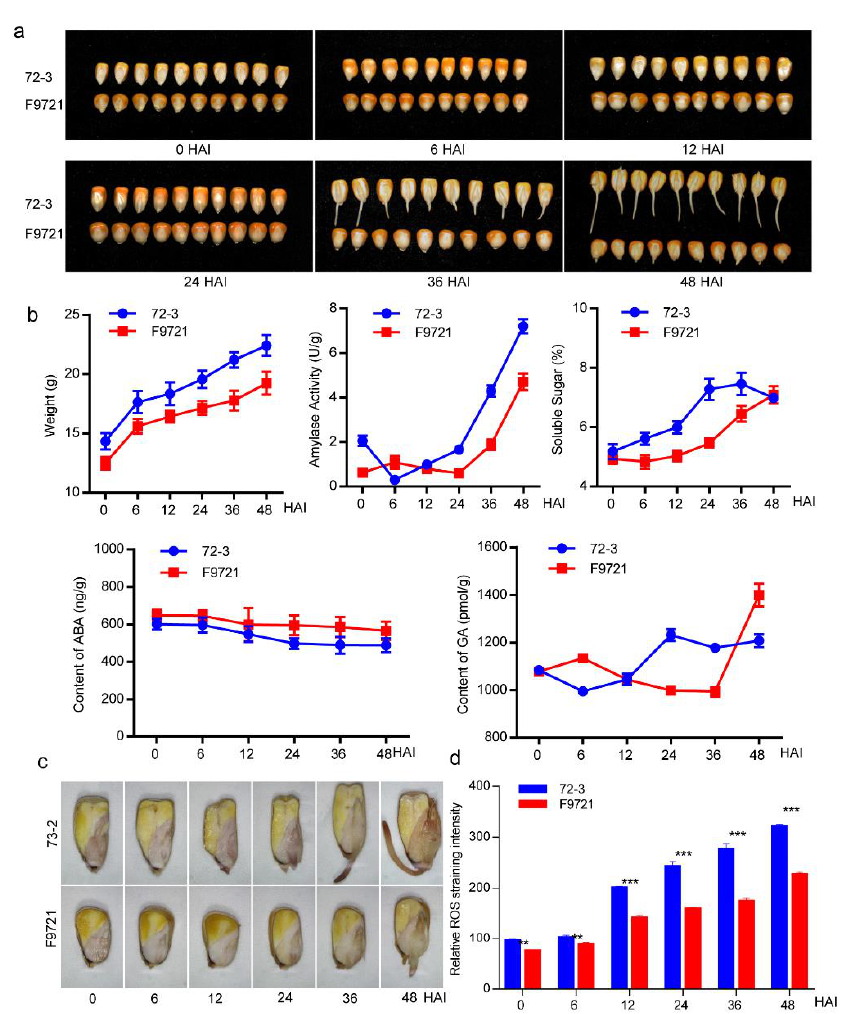
Figure 1. Seed germination process of 72-3 and F9721. ( a ) Comparison of the six germination stages of 72-3 and F9721. ( b ) Dynamic of seed fresh weight, amylase activity, soluble sugar content, and ABA and GA content of the two lines at six germination stages. The content of soluble sugar was quantified as the ratio in 0.1 g flour (%). ( c ) DAB staining for the evaluation of hydrogen peroxide (H 2 O 2 ). ( d ) Quantified DAB staining intensity during seed imbibition. Error bars indicate standard deviation (SD), Student’s t test; ** p < 0.01, *** p < 0.001.